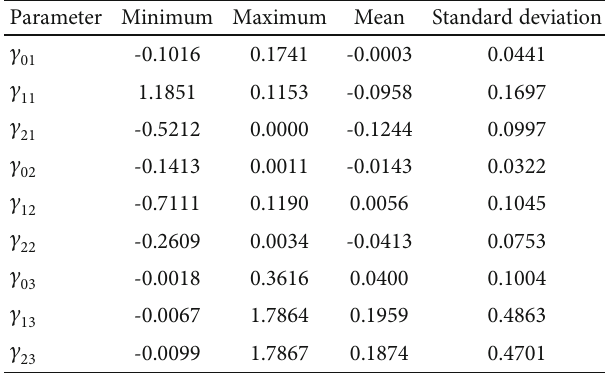
Table 3: The descriptive statistics of the maximum likelihood estimator values for the 55 geographically weighted multivariate logistic regression models.